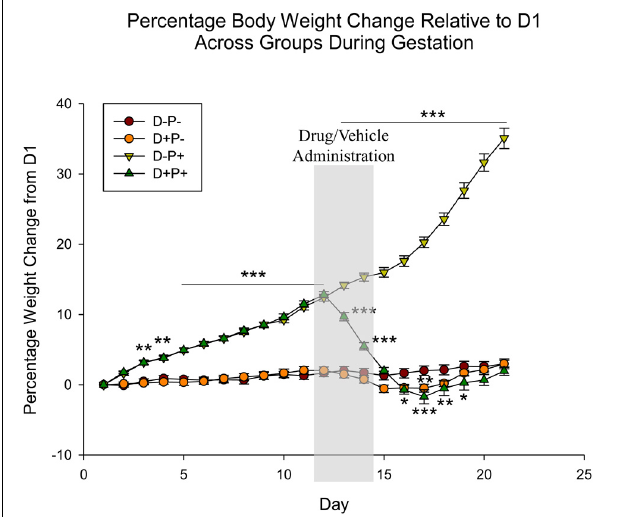
FIGURE 1 | Percentage rat body weight change across gestation period relative to Day 1 (D1) of pregnancy. Following pregnancy termination, rats in the D+P+ group showed significant weight loss, decreasing below baseline (D − P − ). n = 19–20 rats/group; ∗ p < 0.05, ∗∗ p < 0.01, ∗∗∗ p < 0.001 (Relative to D − P − ). Data is expressed as mean ± SEM. Shaded area indicates days of drug/vehicle administration.